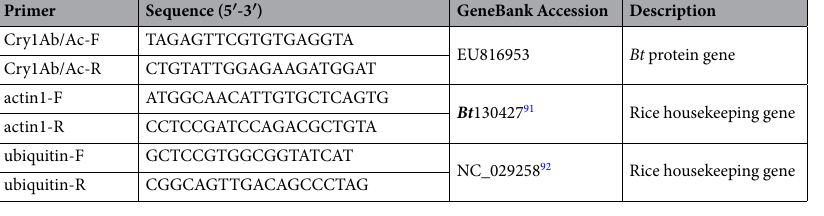
Table 1. Primers for